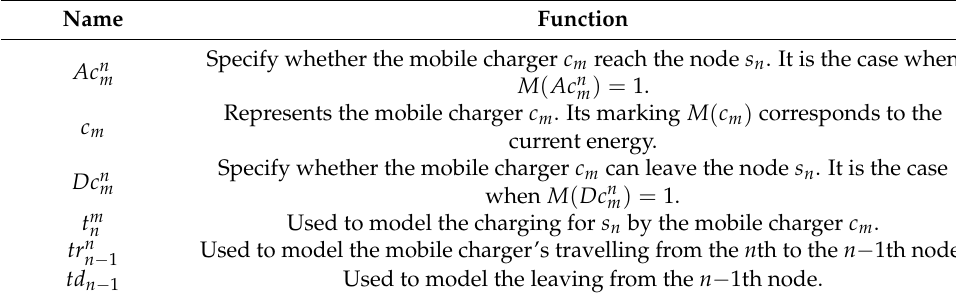
Table 3. Interpretation of place and transition for mobile charging